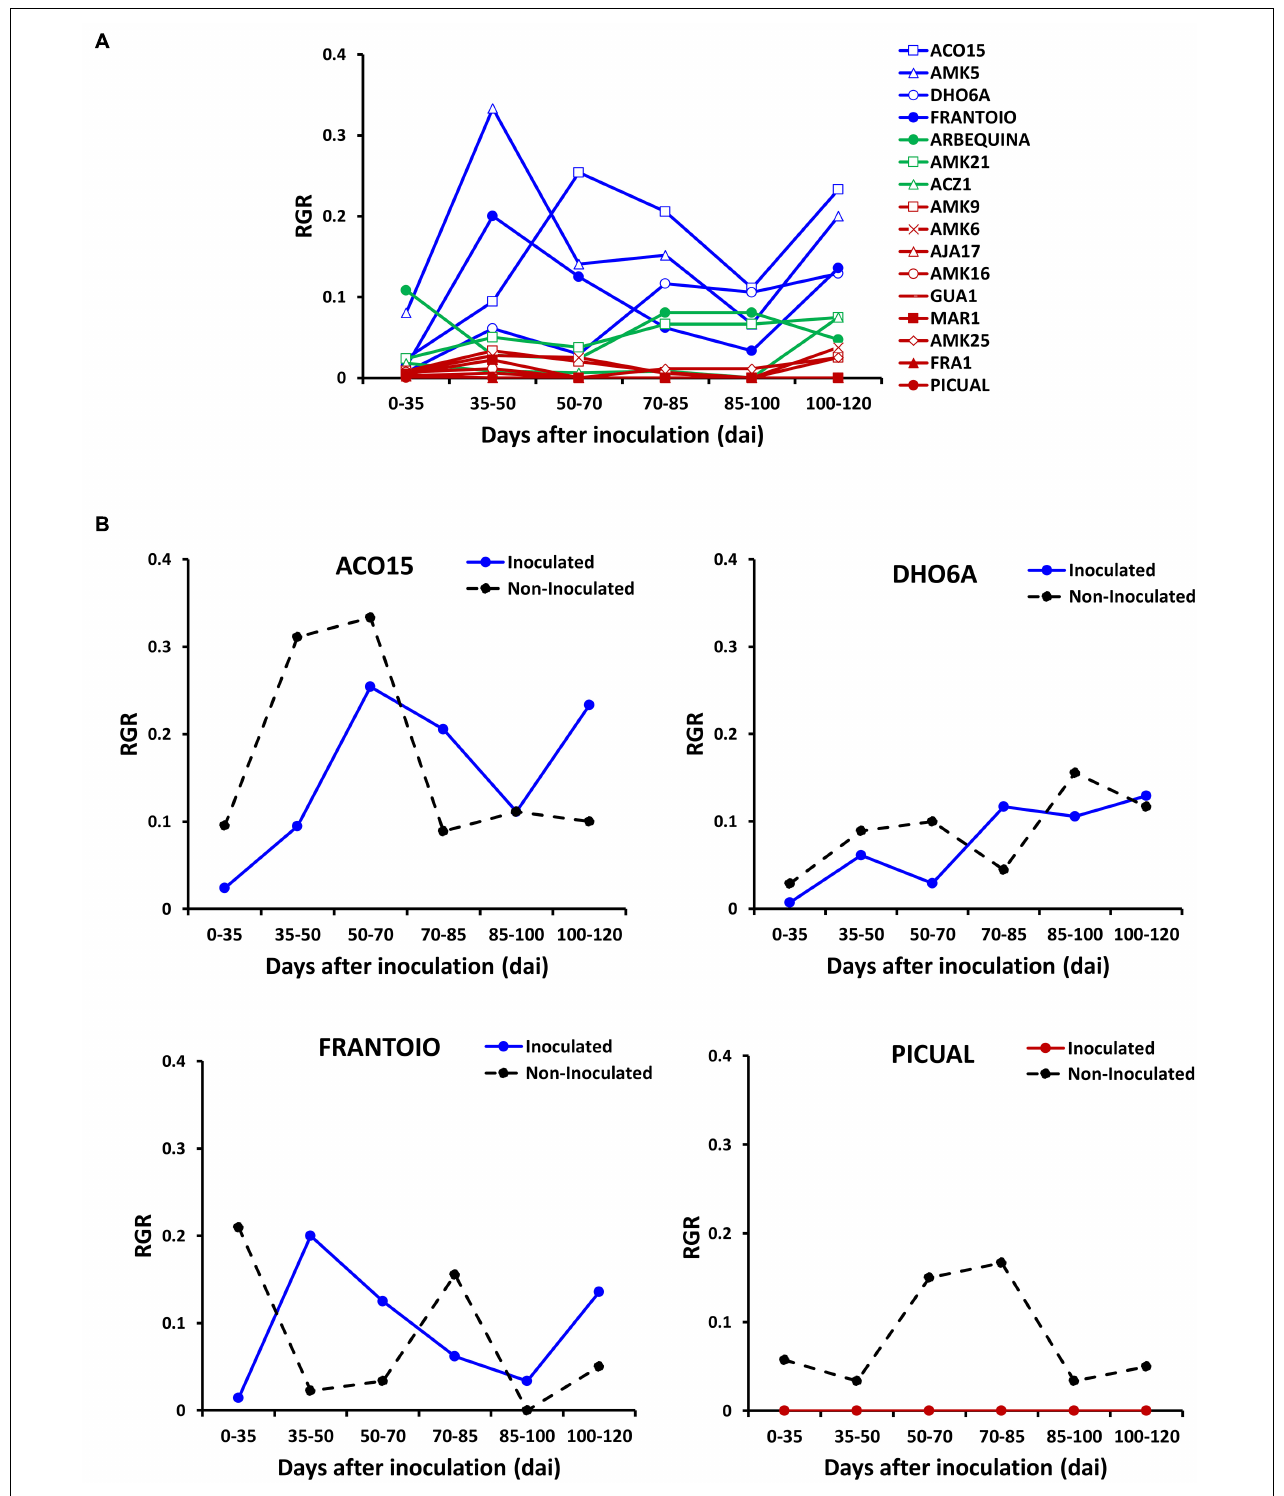
FIGURE 3 | Relative growth rate (RGR) quantified as the production of new nodes per day in wild genotypes and cultivars of assay 3. (A) RGR values of plants inoculated with the defoliating isolate VD117 of Verticillium dahliae were compared between resistant (blue), moderately susceptible (green) and susceptible or extremely susceptible (red) genotypes. (B) Comparison of inoculated (plain lines) vs. non-inoculated (dashed black lines) RGR in resistant wild genotypes and in representative cultivars: resistant Frantoio and extremely susceptible Picual.